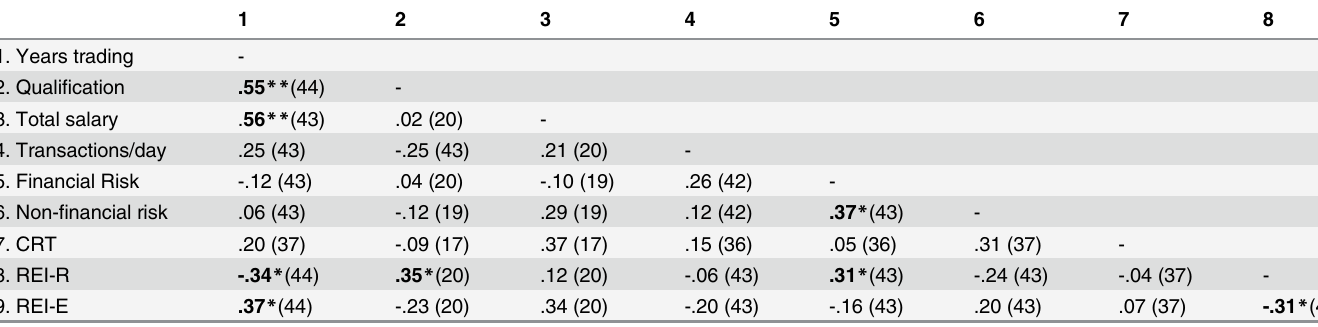
Table 1. Two-tailed correlations between main measures in the trader group (Study 1, n =